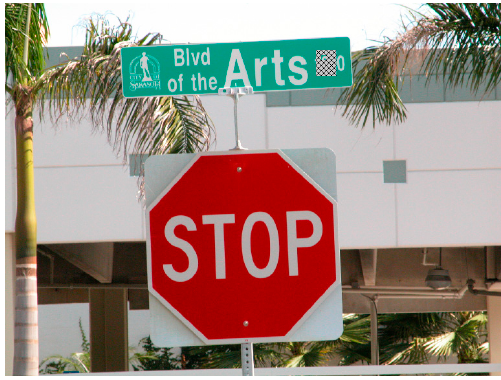
Figure A2. Tampered image (with zoom on tampered detail).